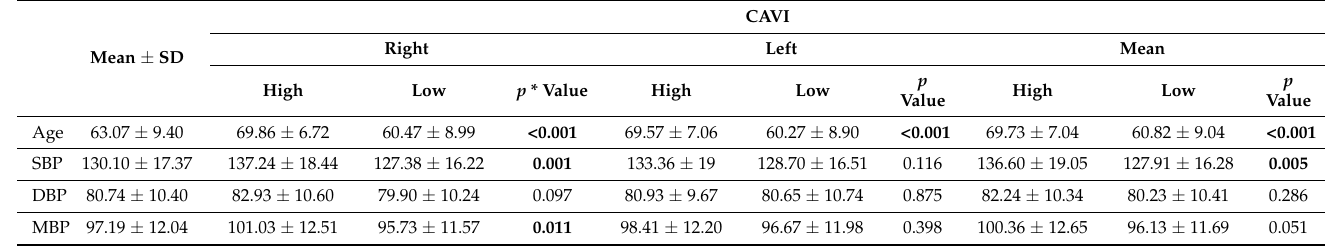
Table 2. Distribution of age and blood pressure indices based on high and low values of right, left, and mean CAVI.